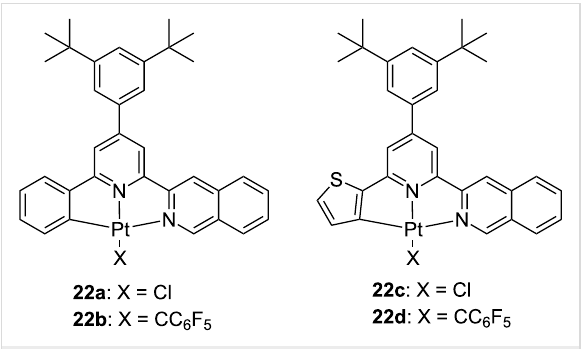
Figure 10: Chemical structure of platinum(II) complexes 22a–d bear- ing asymmetric C^N^N tridentate ligands [53].